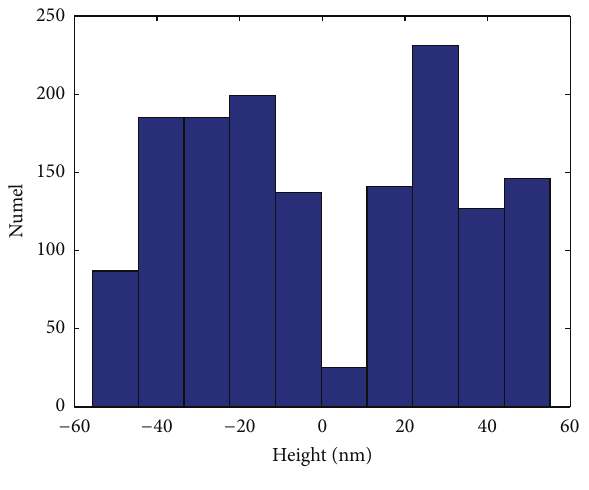
Figure 13: Height